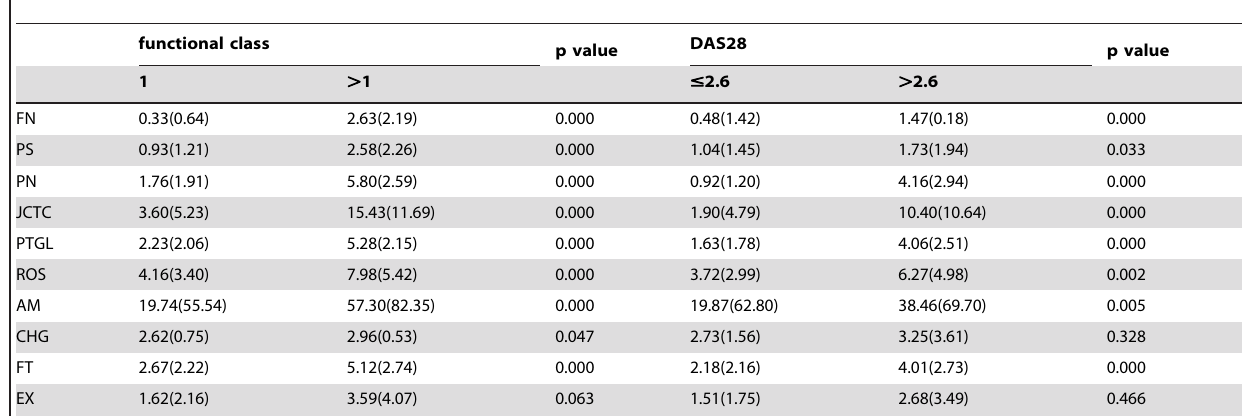
Table 4. Discriminant validity of MDHAQ-C,with functional class and disease activity being the external anchor.